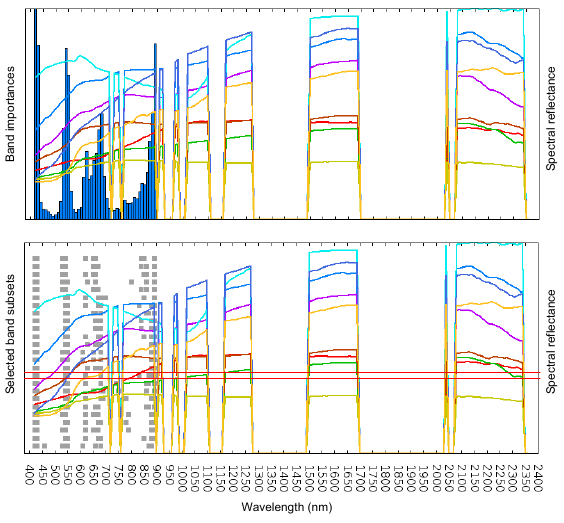
Figure 6: Selected band subsets of 10 bands (top) and band im- portance profiles (bottom) for spectral optimisation in the VNIR (420-1000 nm) spectral domain. (red frame = final solution) hyperspectral set of bands and for the subsets of 10 bands